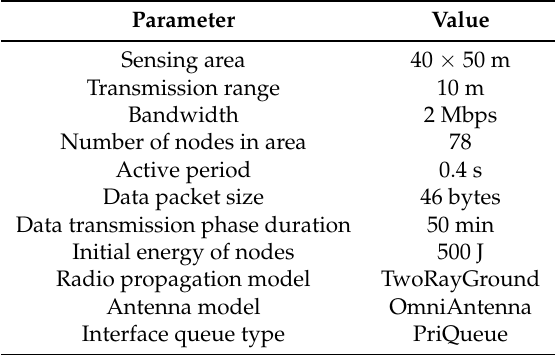
Table 3. Simulation parameters.